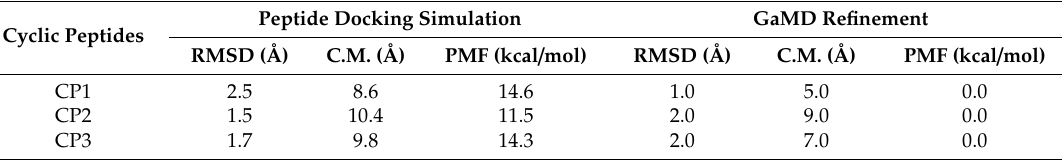
Figure 2. 2D PMF profiles of the backbone RMSDs of UEV binding domain (residue numbers: 61–66, 90–100 and 139–145) and the distances between the centers of the two domains (UEV domain protein residue numbers: 61–66, 90–100 and 139–145; the three cyclic peptides): ( A ) CP1, ( B ) CP2 and ( C ) CP3. Stars mark (cyan) is at the lowest PMFs value of 2D PMF profiles. Table 3. D PMF profile information of the cyclic peptide–UEV domain complex